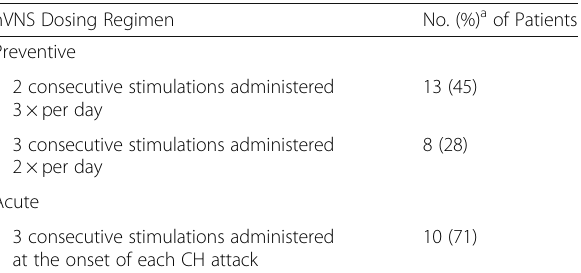
Table 2 Most commonly used nVNS dosing regimens: preventive and acute treatment nVNS Dosing Regimen No. (%) a of Patients